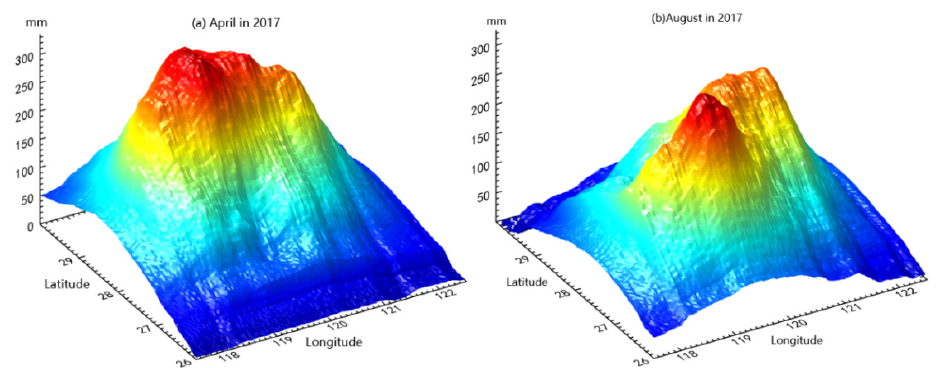
Figure 5. ( a ) The monthly change in groundwater storage derived from a comprehensive calculation of CORS data, taking April 2017 as the examples. ( b ) The monthly change in groundwater storage, taking August 2017 as the examples.